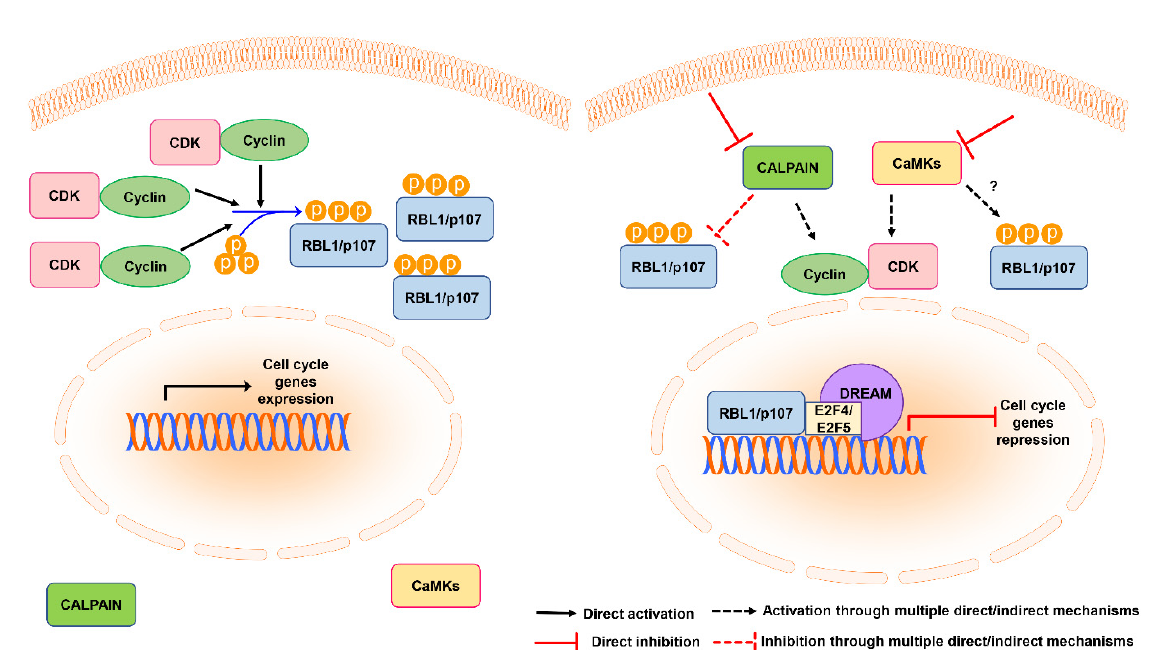
Figure 6. Schematic representation of the model of RBL1/p107 regulation by calpain and CaMKs. In cycling cells RBL1/p107 is phosphorylated by cyclin-CDK complexes, promoting RBL1/p107 cytoplasmic localization ( left panel). Calpain inhibition or CaMK inhibition promote RBL1/p107 dephosphorylation and nuclear accumulation by directly or indirectly affecting its stability or the activity/levels of cyclins and CDKs. RBL1/p107 nuclear accumulation might increase the localization of transcriptional repressors at the promoters of genes controlling cell cycle progression, contributing to cell cycle arrest ( right panel).